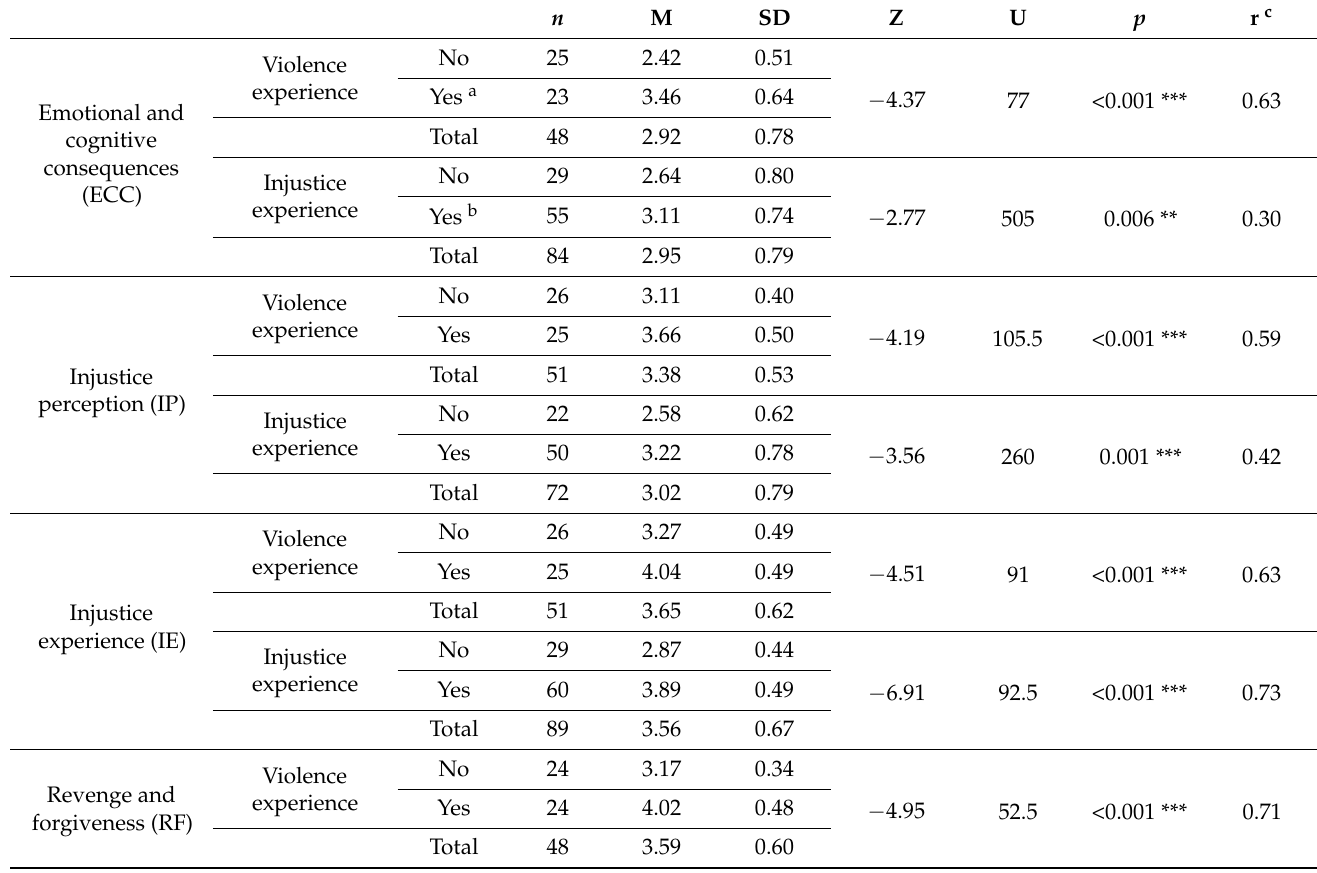
Table 3. Mann–Whitney U test tables for mean values of